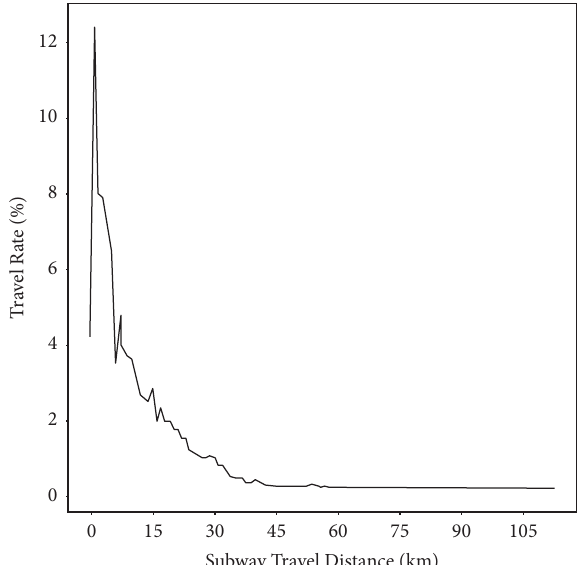
Figure 14: Subway travel distance distribution.